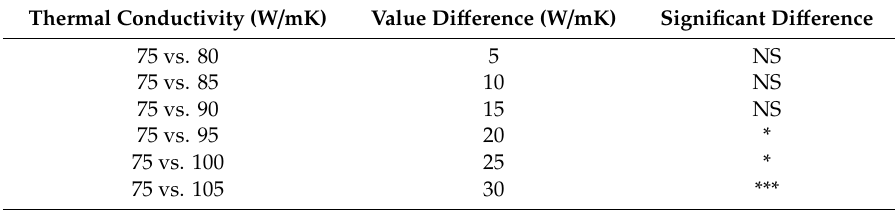
Table 1. Result of threshold experiment by using significant di ff erent judgement.